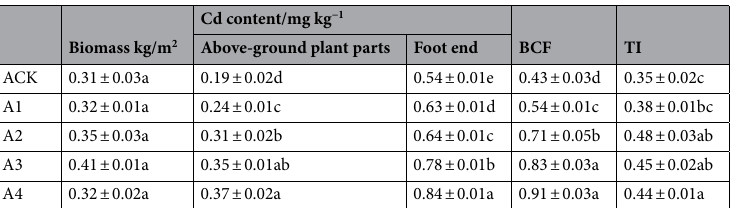
Table 2. Cd content and enrichment, and transport coefficient of maidenhair in different GLDA treatments. In the figure, there is a significant difference between different treatments for lower case letters ( p ＜ 0.05), the same